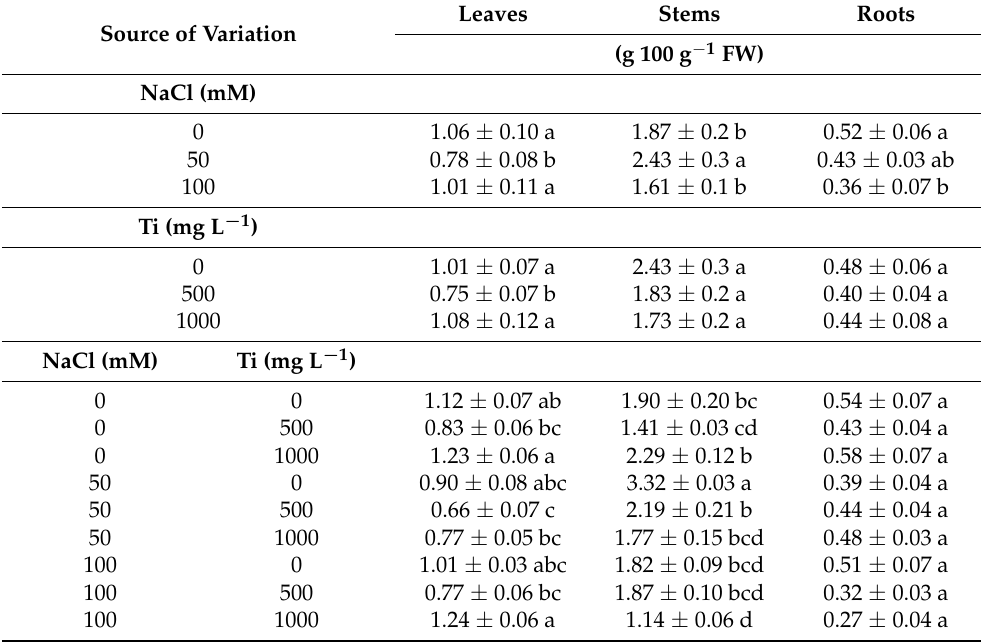
Table 4. Main and interaction effects of NaCl and TiO 2 on sugar concentration on tomato ( Solanum lycopersicum L.) seedlings cv. Rio